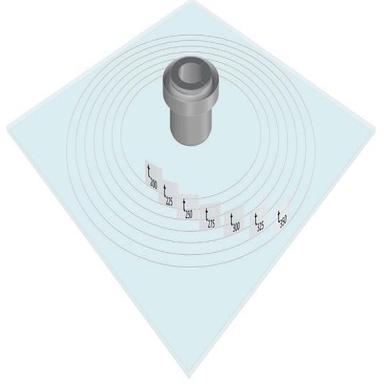
Slump flow time measurement steps for determining viscosity using the C-test.